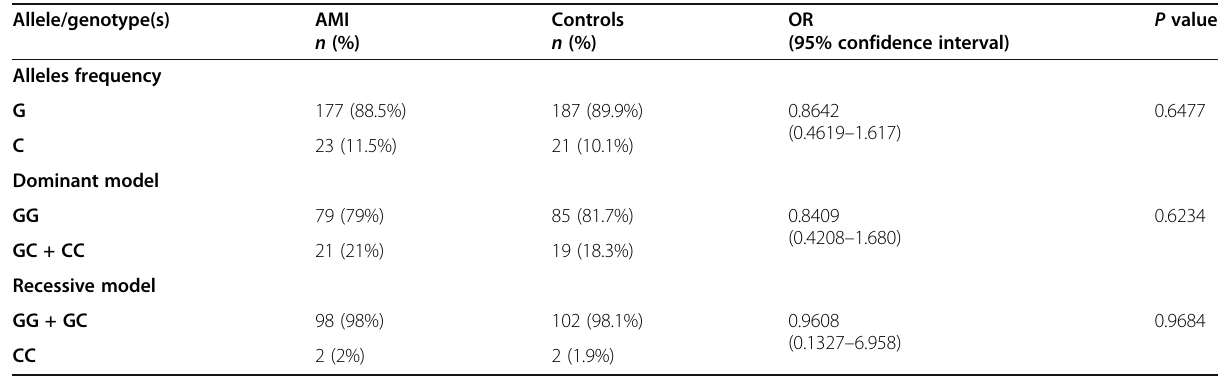
Table 2 Alleles and genetic models for IL-6 G174C SNP in AMI patients and controls